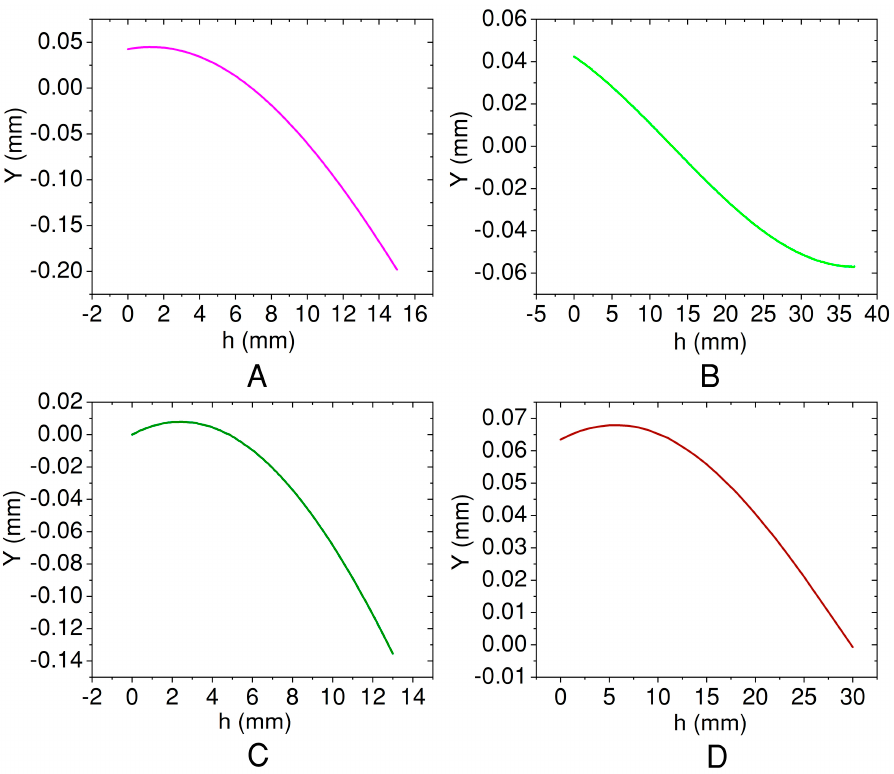
Figure 7. Ordinates distribution of ( A – D )-type end milling cutter.